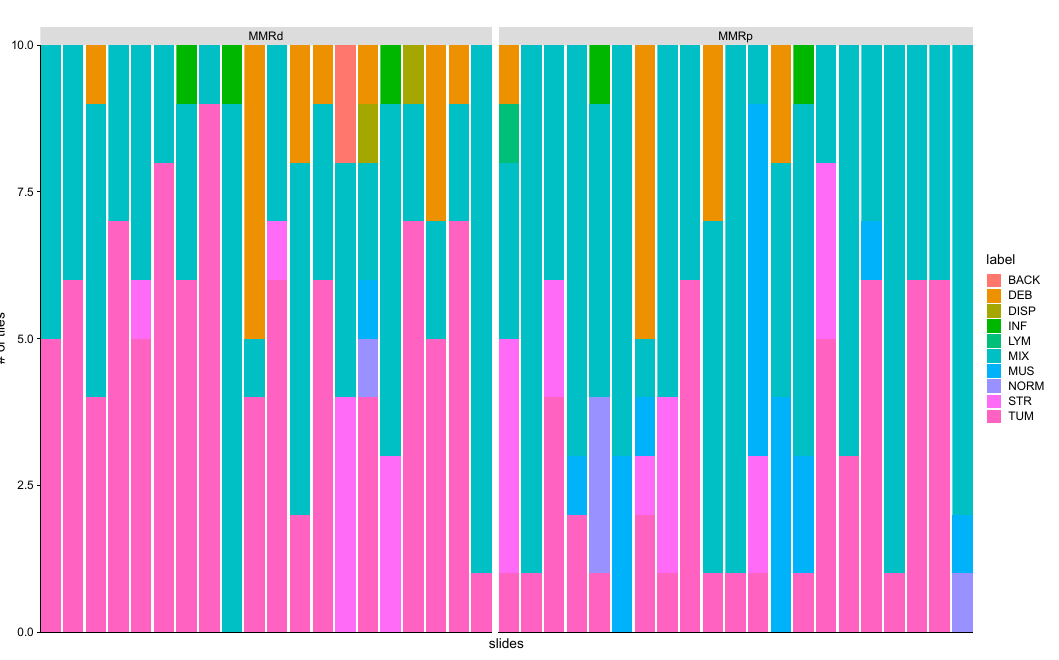
Figure 3. Tissue classes learned from convolutional neural network (CNN) in stomach cancer. Examples from mismatch repair deficiency (MMRD) and mismatch repair proficiency (MMRP) groups. The bar represents the spectrum of histologic diversity in the test set and it contains the top-ranking tiles per slide learned from CNN. These tiles were manually annotated by two pathologists among the following ten tissue labels: ADI, adipose tissue; BACK, background; DEB, debris; DIS, dysplasia; INF, inflammation; LYM, lymphocytes; MUS, smooth muscle; NORM, normal gastric mucosa; STR, cancer-associated stroma; TUM, gastric adenocarcinoma epithelium.